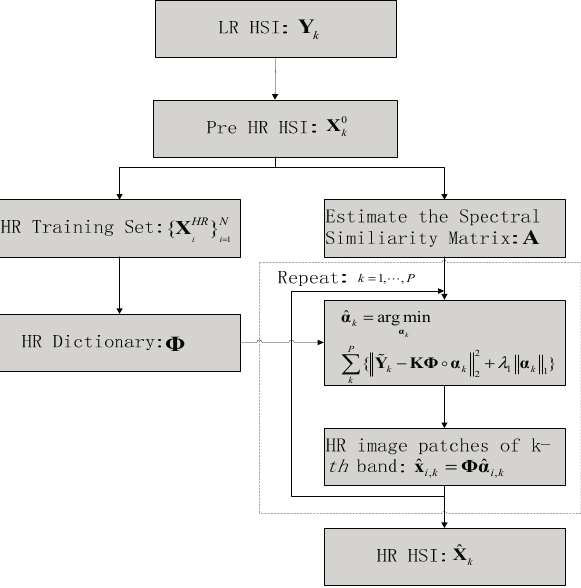
Figure 1. Flowchart of the proposed